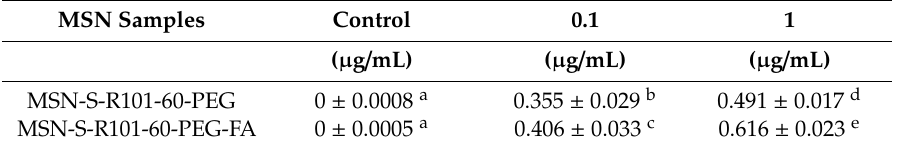
Table 4. Quantification ( µ g / mL) of MSN-S-R101-60-PEG and MSN-S-R101-60-PEG-FA internalized into HeLa cells after 24 h exposure to 0.1 and 1 µ g / mL of each MSN sample (mean ± SD). Di ff erent letters indicate significant ( p < 0.05) di ff erences among groups. MSN Samples